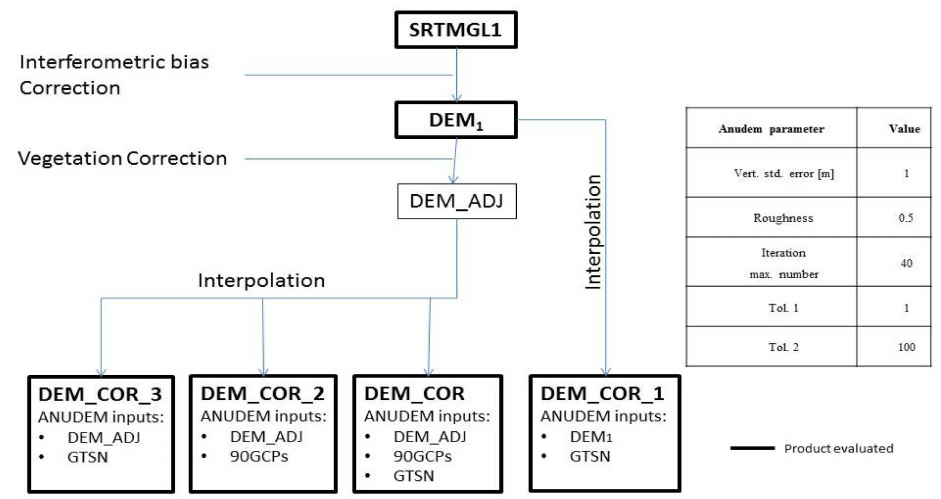
Figure 3. Flow chart of the generation of the different digital elevation models (DEMs) evaluated, accompanied by values of ANUDEM